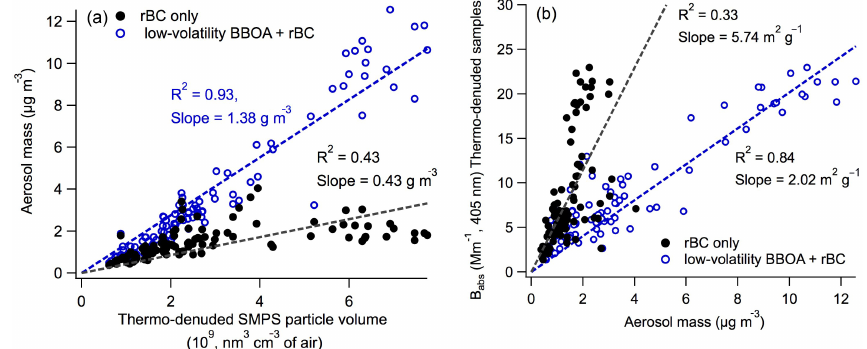
Figure 5. (a) Correlation of the estimated total of non- and low-volatility aerosol mass (rBC + 60% of the total BBOA) and thermo- denuded particle volume measured by the SMPS. (b) Correlations of aerosol absorption at 405nm of thermo-denuded particles ( B abs ) and the estimated total of non- and low-volatility aerosol